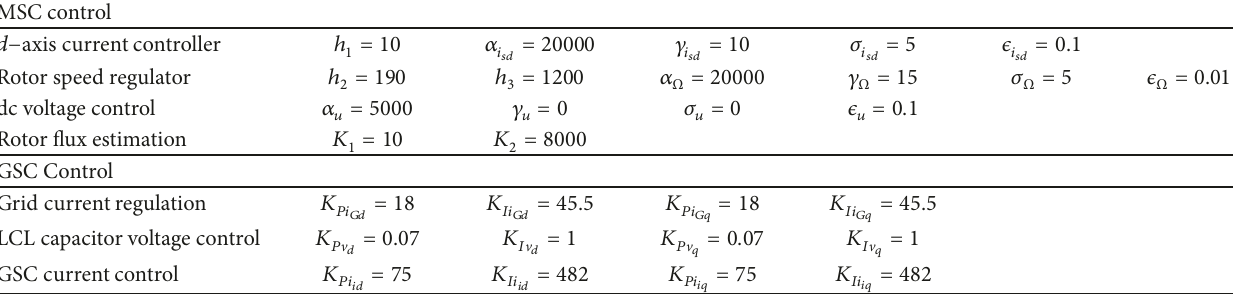
Table 2: Numerical values of control